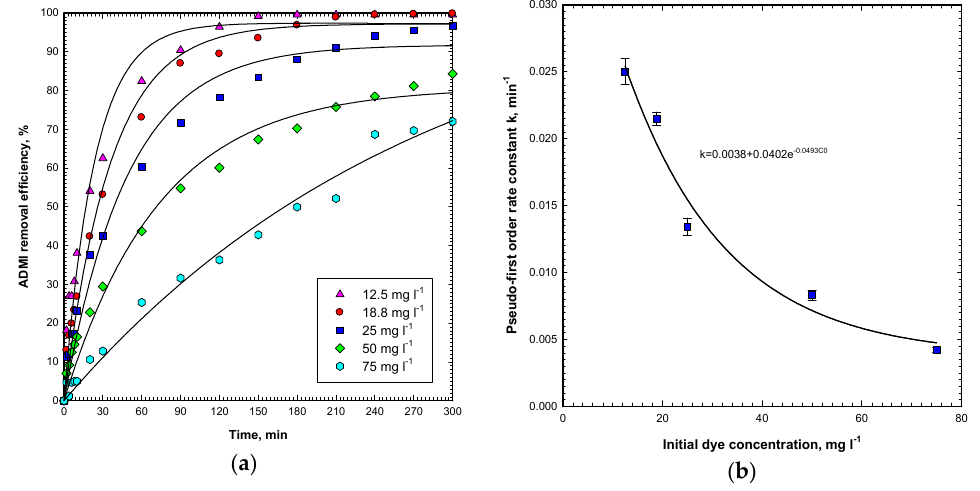
Figure 4. Effect of initial OG concentration on ( a ) OG degradation and ( b ) the pseudo-first-order rate constant by the Vis/ZnO process. The operating conditions were: initial OG concentration of 12.5–75 mg L − 1 , ZnO dosage of 60 g m − 2 , visible light intensity of 9600 Lux, and reaction time duration of 300 min.